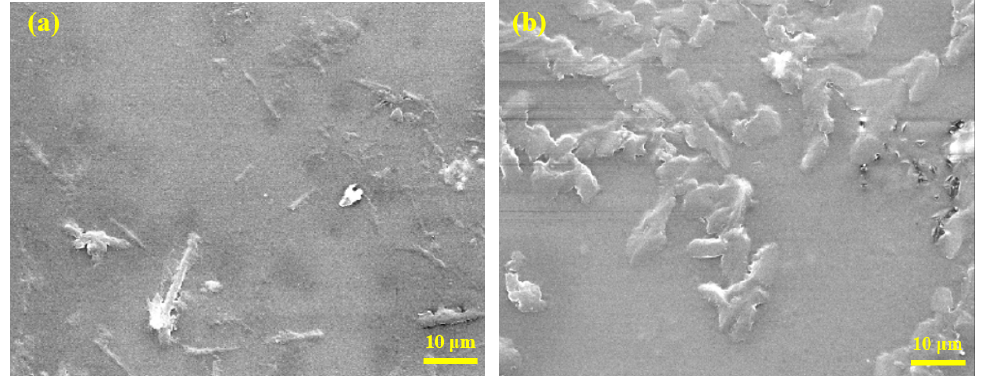
Figure 13. The SEM micrographs of PMMA-BDK-MR polymer composite thin films: ( a ) without curing and ( b ) with curing [48].